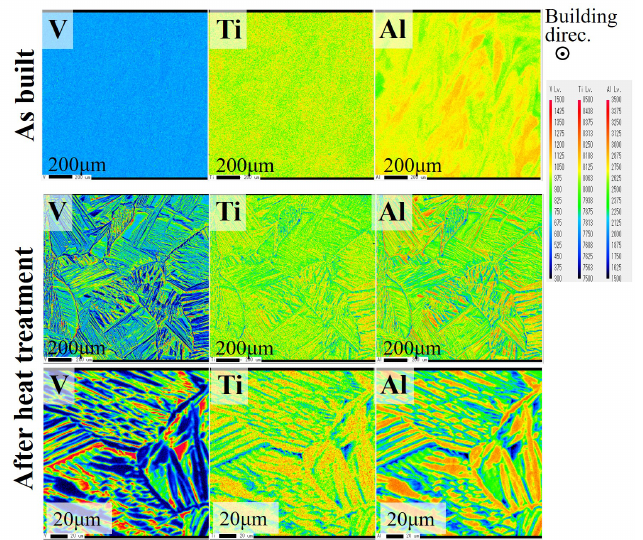
Figure 10. EPMA analysis of major elements before ( upper ) and after ( middle and lower ) heat treatment Pattern